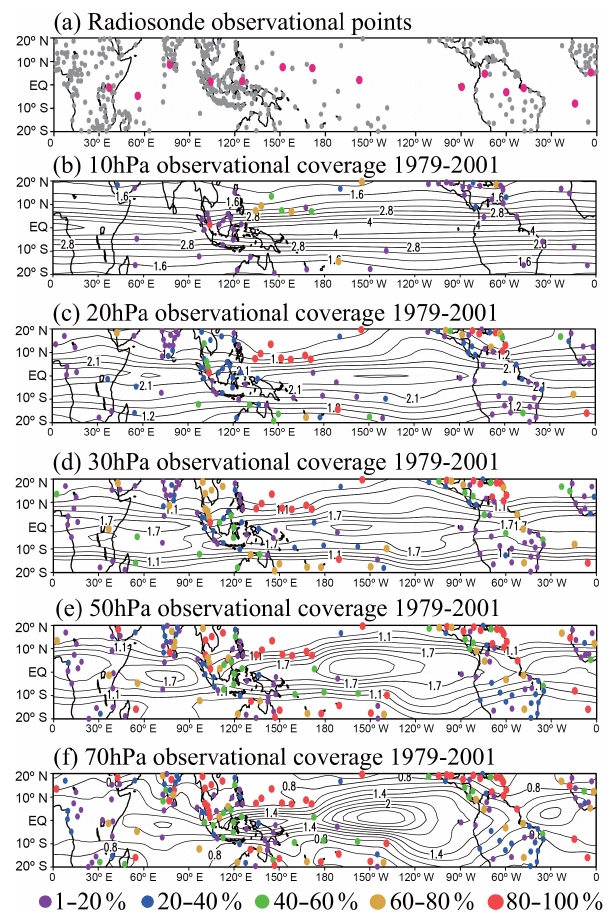
Figure 5. (a) Locations of all IGRA stations in the tropical re- gion (magenta dots indicate the locations of the stations shown in Fig. 6). (b–f) IGRA stations with data coverage of (purple) 1–20%, (blue) 20–40%, (green) 40–60%, (yellow) 60–80%, and (red) 80– 100% at (b) 10, (c) 20, (d) 30, (e) 50, and (f) 70hPa during 1979– 2001. The contours show the standard deviation among reanalyses as shown in Fig. 4. The contour intervals at each height are the same as in Fig.